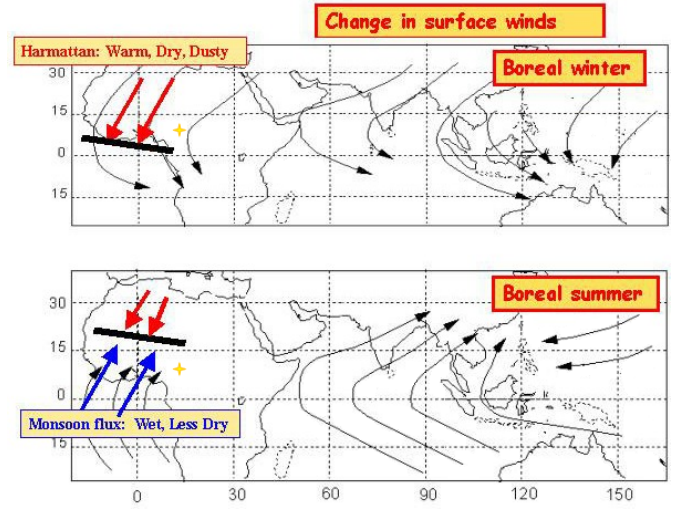
Figure 1. Schematic picture of the seasonal meteorological circulations in West Africa from http://www.amma-international.org/spip.php?article10. The yellow stars indicate the geographical position of